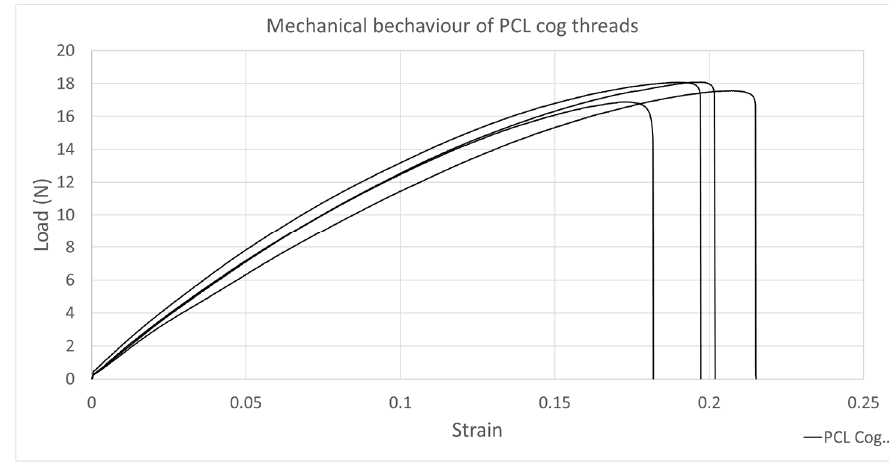
Figure 5. Mechanical behavior of PCL cog threads under uniaxial tensile loading ( n = 4).